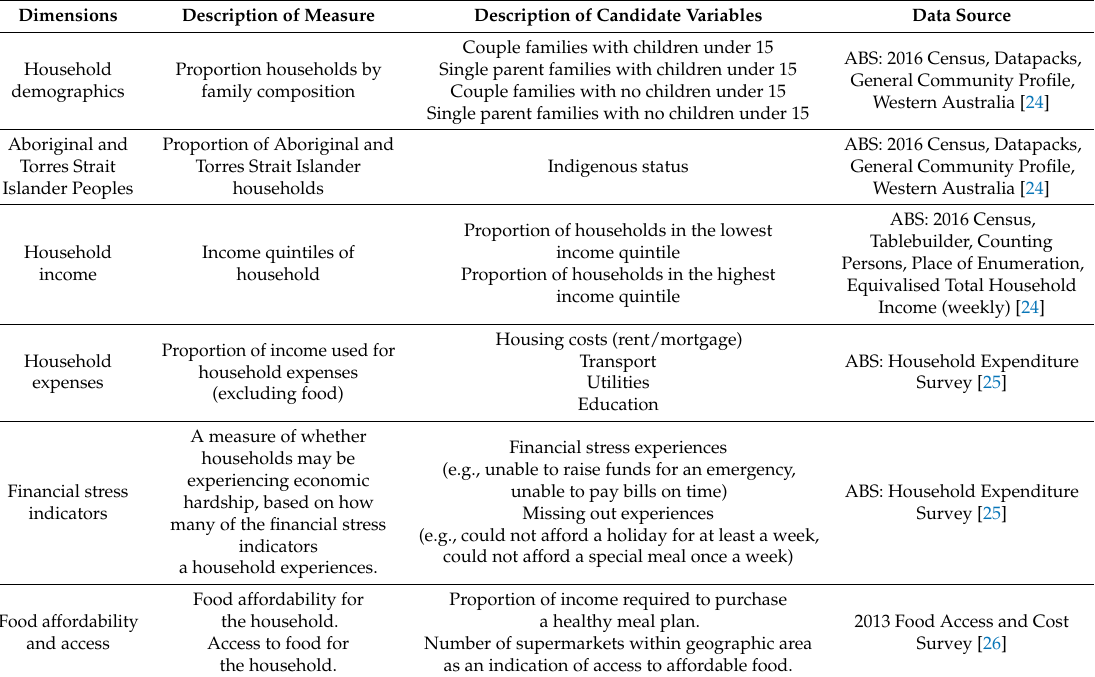
Table 1. Candidate variables for a Food Stress